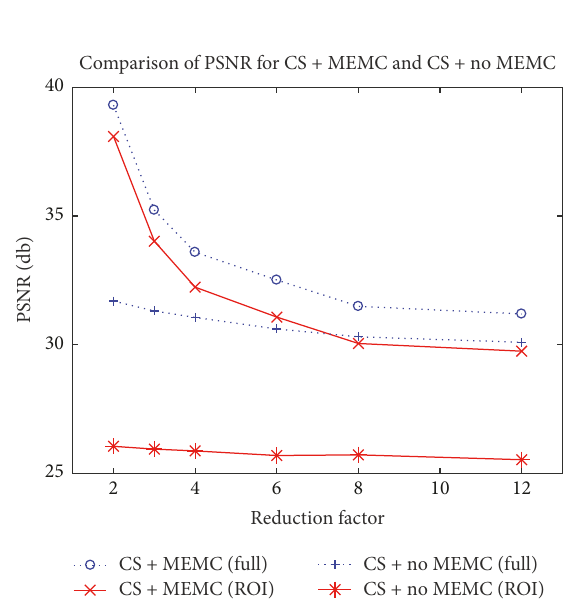
Figure 7: Performance comparison of SSIM at different reduction factors for CS-free breathing without MEMC and CS-free breathing with MEMC. Dotted lines depict SSIM over the full image and solid lines show SSIM in the region of interest